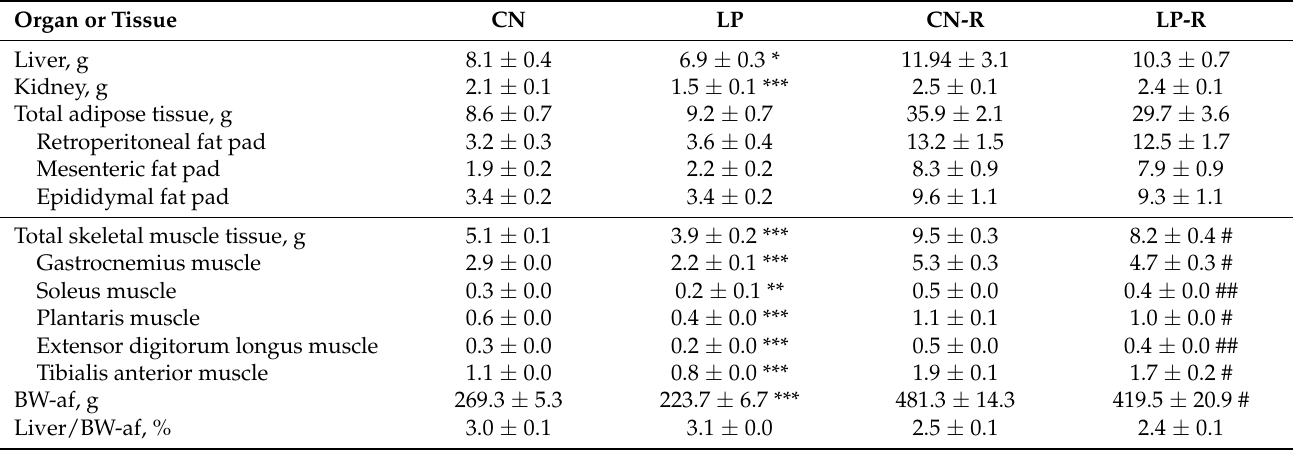
Figure 1. Changes in calorie intake and body weight. ( A ) Final body weight; ( B ) Total calories intake; ( C ) Weight change throughout the experiment; ( D ) Weekly food intake. Data are shown as means ± standard error of the mean (SEM), n = 6 or 7. CN, control diet (15% casein); LP, low-protein diet (8% casein); CN-R, rebound feeding group fed with control diet after 4 weeks of normal feeding; LP-R, rebound feeding group fed with control diet after 4 weeks of low-protein diet feeding; ns, no significance; ** * p < 0.001 vs. CN. # p < 0.05, # # p < 0.01, and ## # p < 0.001 vs. CN-R. Table 1. Absolute or relative organ/tissue weight at the end of the